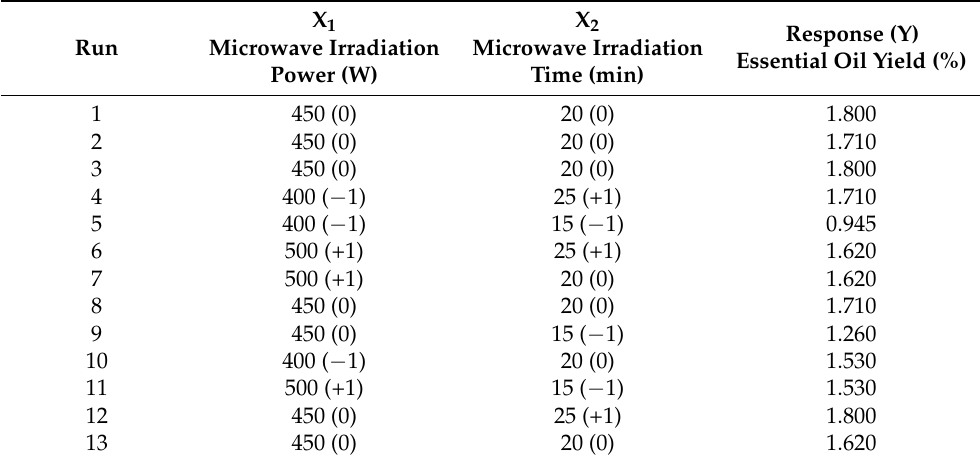
Table 1. Experimental design matrix to screen the important variables for the extraction yield of L. cubeba fruit essential oil as the